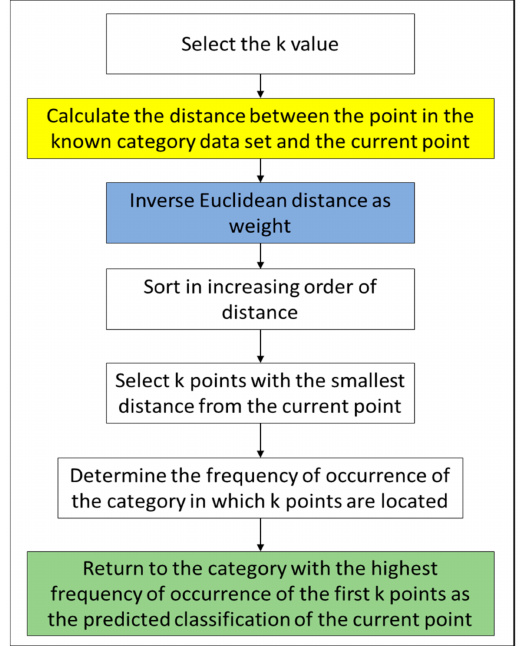
Calculate the weight (shown in the blue block in Figure 7) and reciprocate the distance between the test point and the RP, as shown in Equation (7). WKNN is an improved algorithm for KNN to further improve accuracy. The intuition behind WKNN, is to give more weight to the points which are nearby and less weight to the points which are farther away [28]. In this paper, the weight is selected as the difference between the signal strength corresponding to each RP (fingerprint node) and the sum of the signal strength of each TP (Test Point) node.